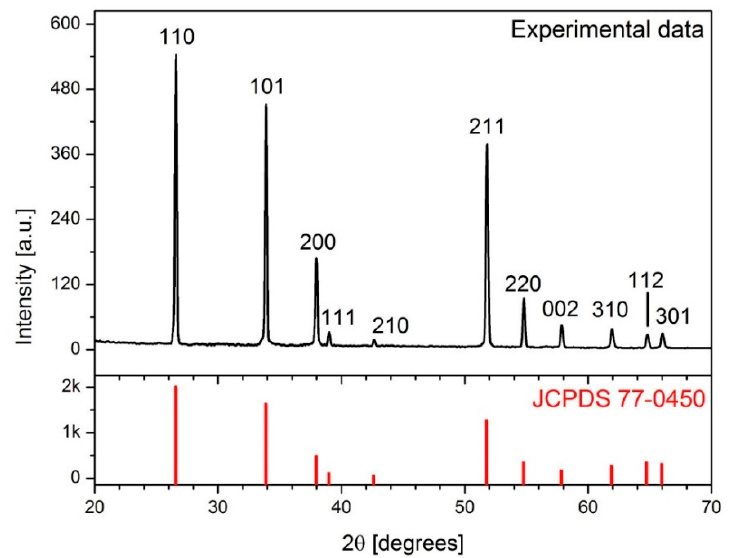
Figure 2. XRD patterns. Top : pattern of SnO 2 nanowires used as a single-nanowire sensor; bottom (red online): reference pattern of tetragonal SnO 2 (JCPDS 77-0450).